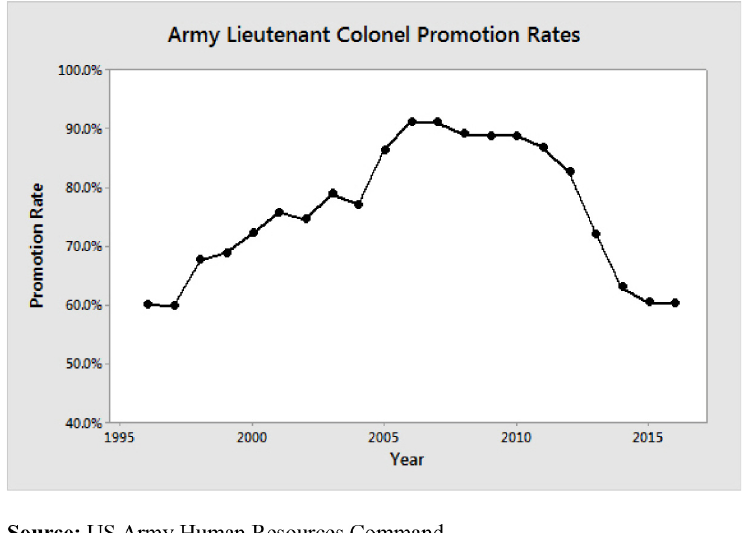
Figure 1. Historical active